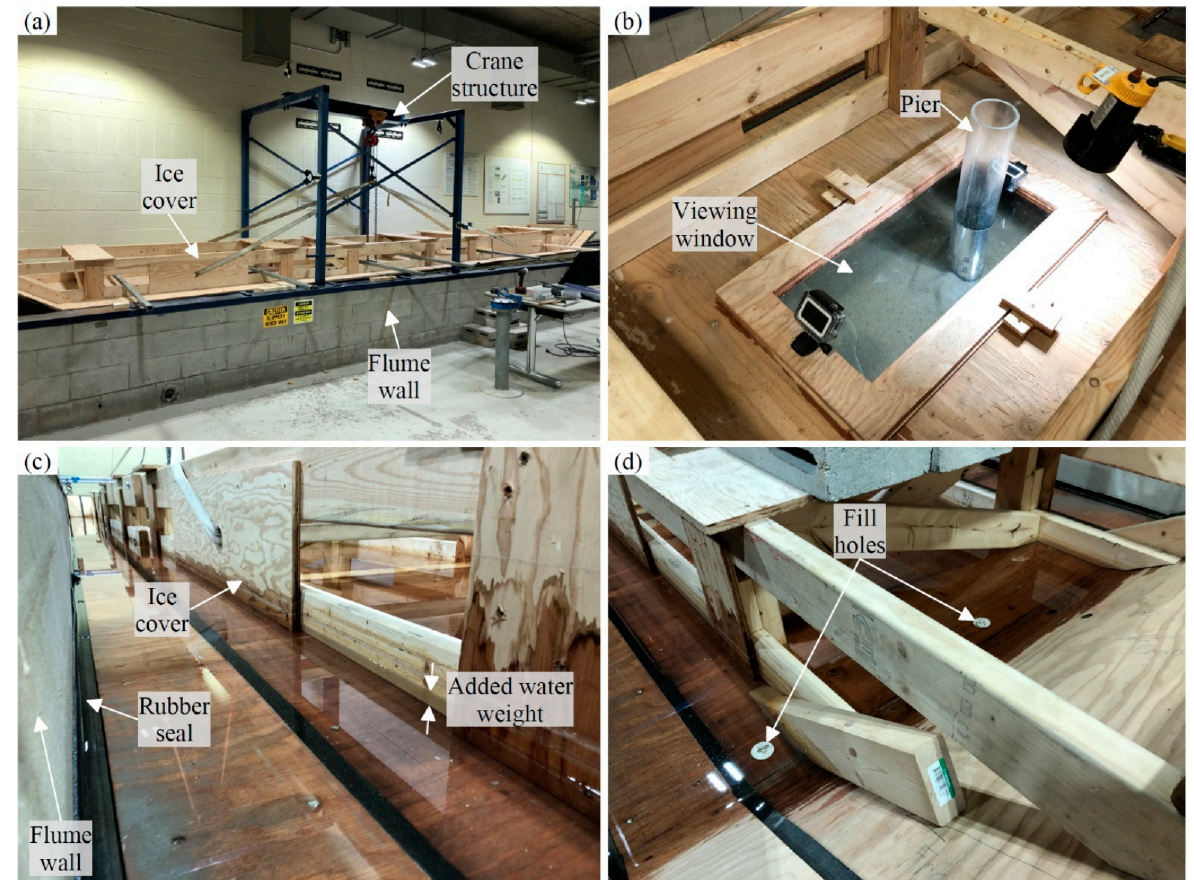
Figure 2. Ice cover apparatus: ( a ) ice cover resting above the flume to allow for the flow conditions to be set, ( b ) pier protruding through the ice cover, ( c ) top view of the ice cover, and ( d ) fill holes used to allow the added water weight to enter above the ice